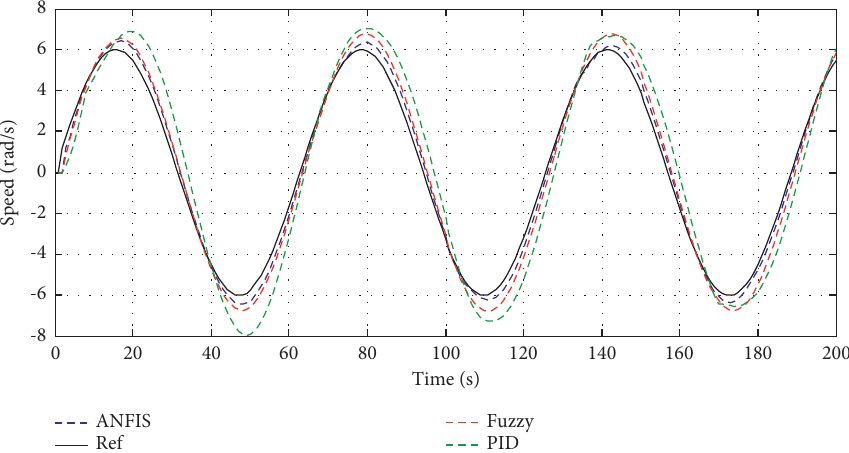
Figure 10: Reference speed and motor speed using ANFIS, Fuzzy, and PID by halving the (R) and (L) (motor